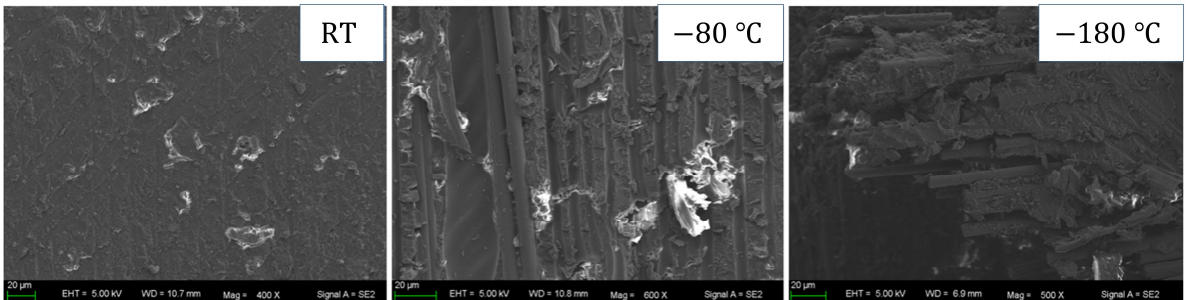
Figure 8. SEM image of the damage location after dynamic compression at di ff erent temperatures.